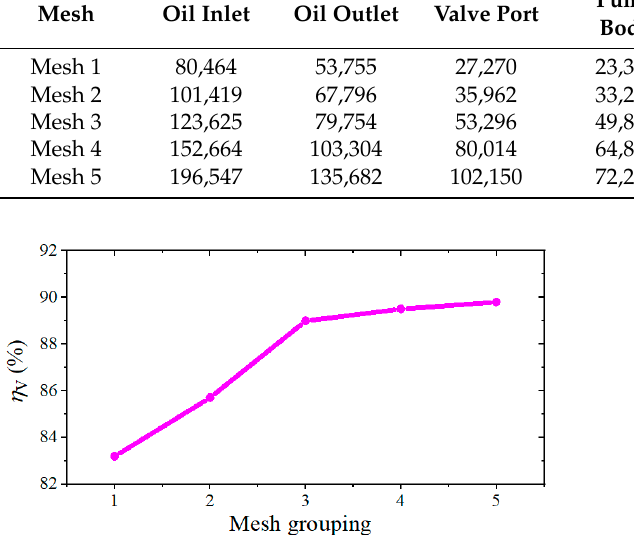
Figure 7. Comparison results of volumetric efficiency (VE) of different mesh models.